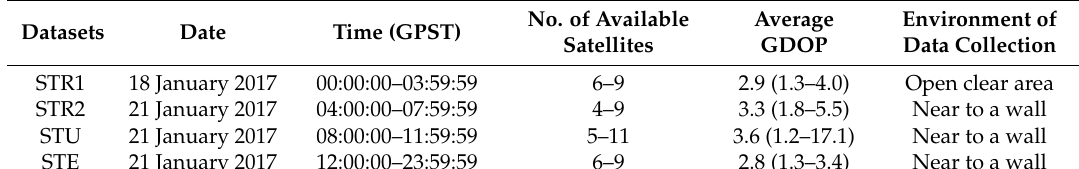
Table 5. Details of the collection of the real static data.